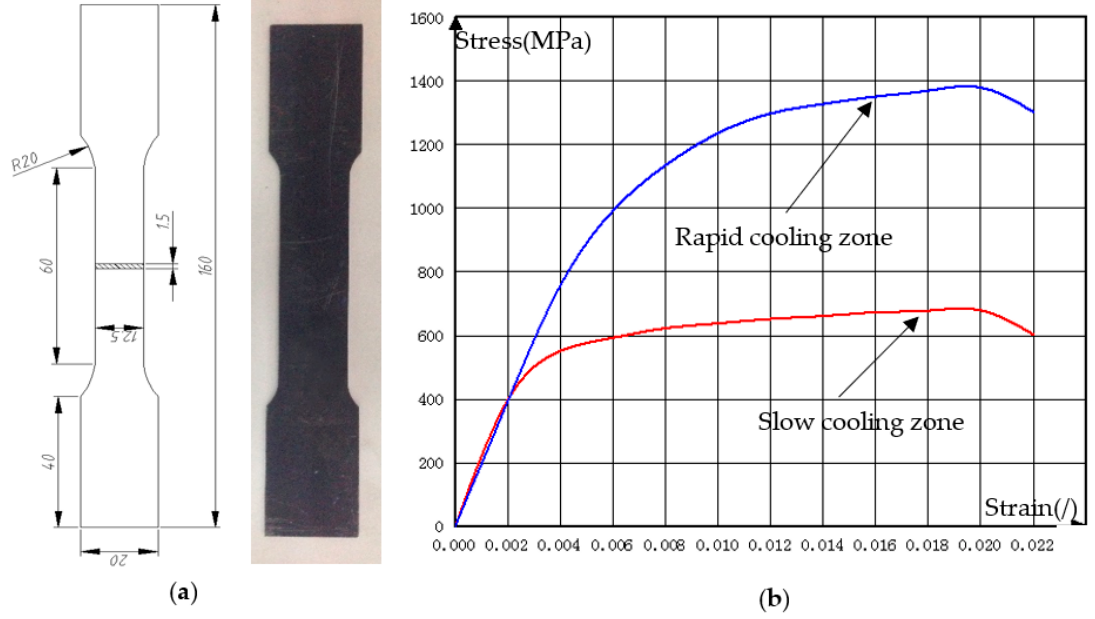
Figure 18. ( a ) Tensile testing specimens and ( b ) tensile strength curves of the B ‐ pillar.